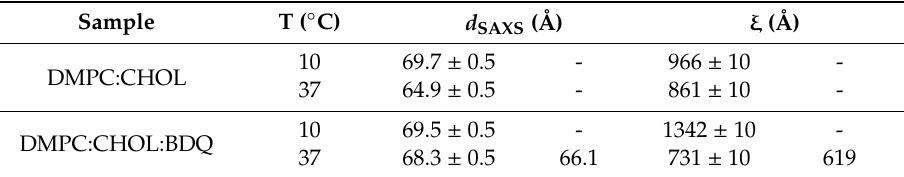
Table 3. SAXS di ff raction profiles of DMPC:cholesterol (CHOL) and DMPC:CHOL with BDQ at 5% molar ratio at 10 and 37 ◦ C.